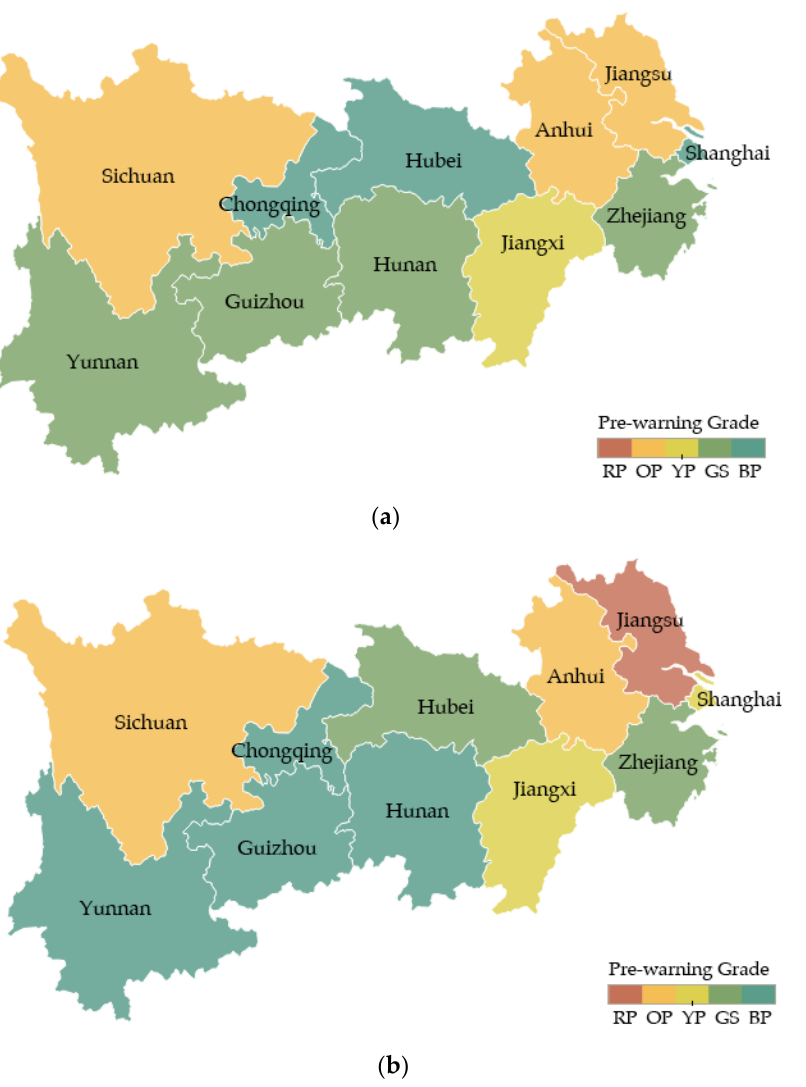
Figure 9. Evaluation results of the water security situation and pre-warning levels from the per- spective of water-energy and water-food symbiosis: ( a ) from the perspective of water-energy; ( b ) from the perspective of water-food.